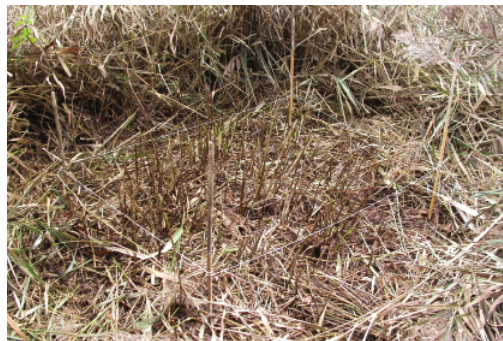
Figure 3: Northend STW tertiary treatment reed-bed, Warwick- shire, November 2006 illustrating reed density quadrat. A reed density quadrat is shown here as an example of one of the features measured at each reed-bed site. Reed density was found to have a negative e ff ect on invertebrate